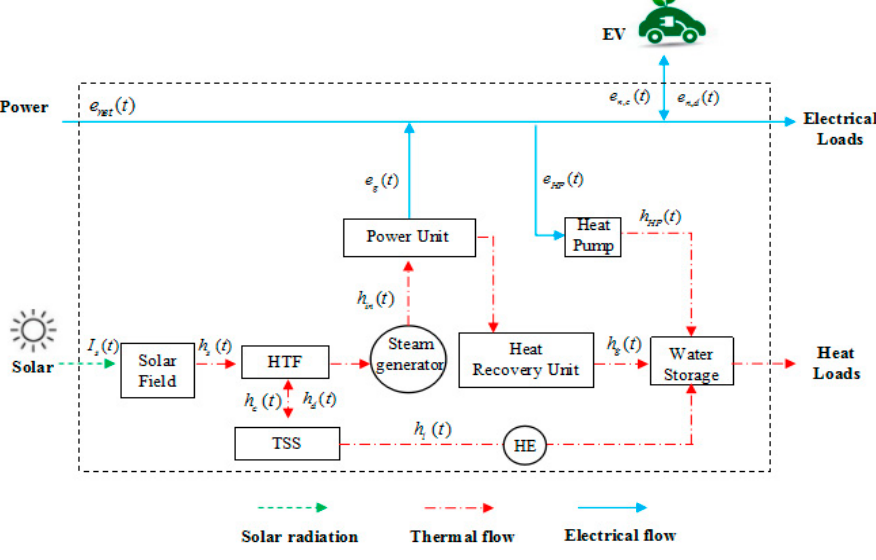
Figure 3. The proposed residential quarter energy hub model.